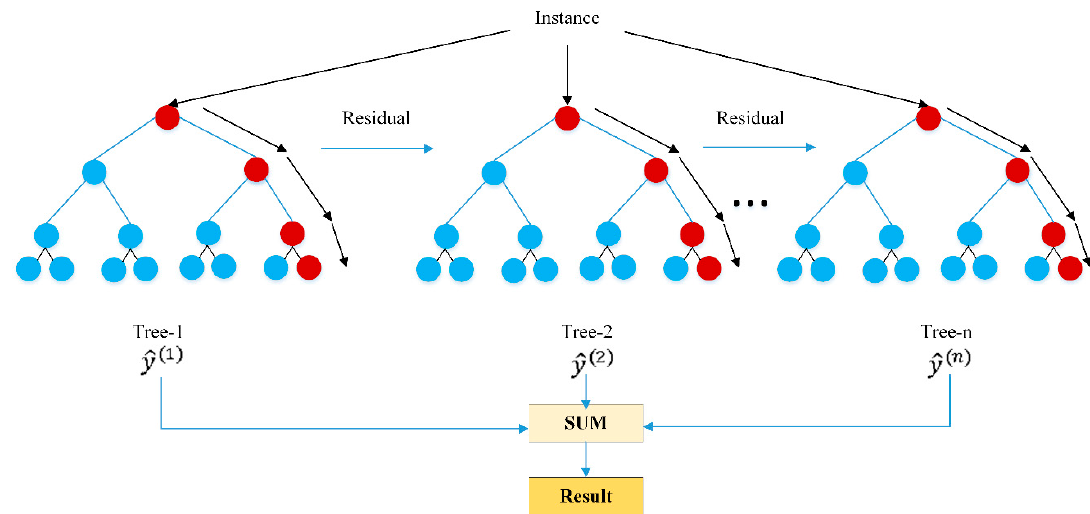
Figure 3. 𝑋𝐺𝐵𝑂𝑂𝑆𝑇 mechanism. Figure 3. XGBOOST